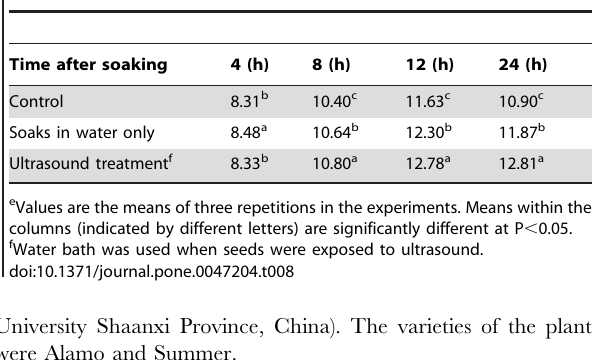
Table 8. Electrical conductivity of switchgrass e of the three treatment groups: control, seeds soaked in water and soaked in water in ultrasonic device after 4 to 24 h of soaking.